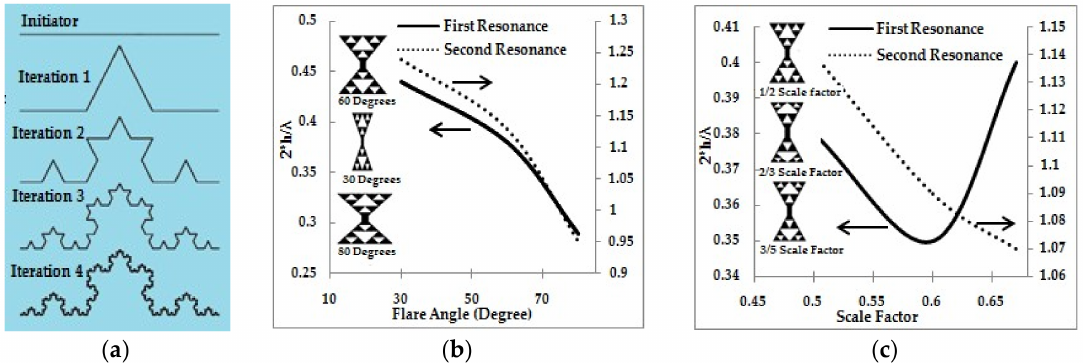
Figure 8. ( a ) Koch curve generation [76]. Effect on resonant frequency for the Sierpinski dipole FSS with ( b ) variation of flare angle ( c ) variation of scale factors